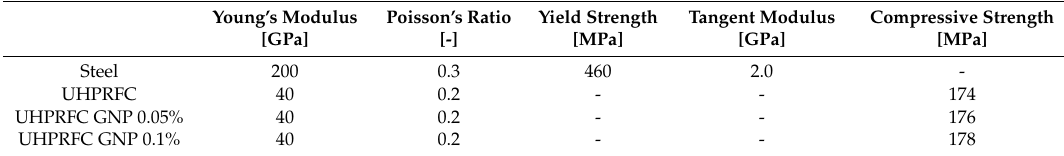
Table 3. Main mechanical properties of UHPFRC and steel